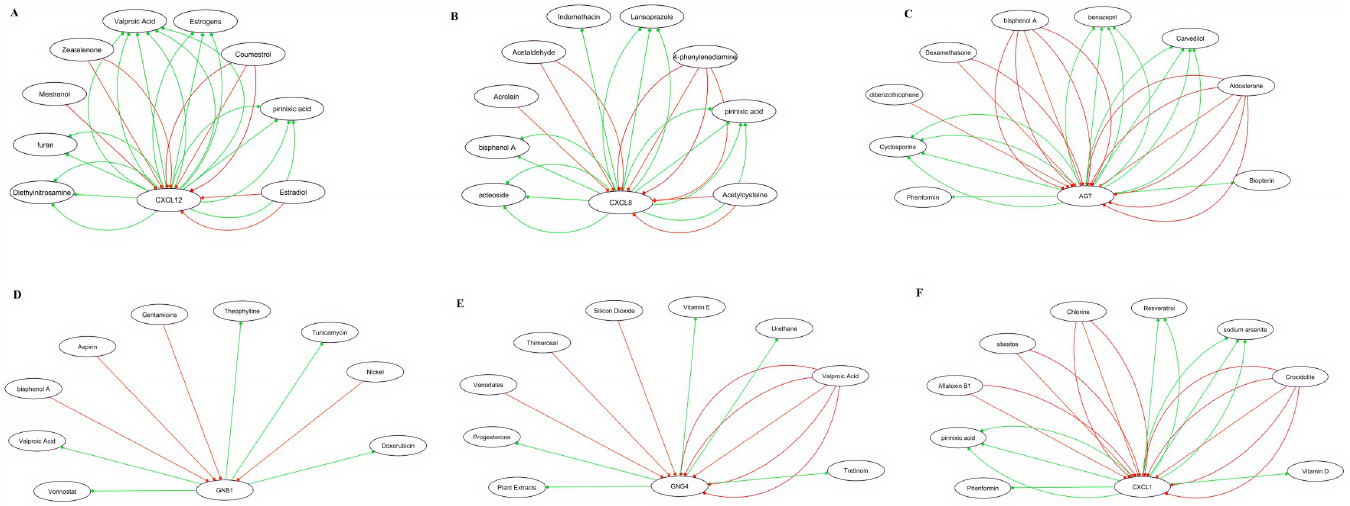
Fig 16. Real hub gene-drug interaction network of the identified real hub genes. Panels A–F indicates the available chemotherapeutic drugs in CTD that decrease or increase the expression levels of the real hub genes. (A) Real hub gene-drug network of CXCL12; (B) Real hub gene-drug network of CXCL8; (C) Real hub gene-drug network of AGT; (D) Real hub gene-drug network of GNB1; (E) Real hub gene-drug network of GNG4; (F) Real hub gene-drug network of CXCL1. Red arrows indicate the chemotherapeutic drugs that could increase the expression levels of the real hub genes, while green arrows indicate the chemotherapeutic drugs that could decrease the expression levels of the real hub genes. The numbers of arrows between chemotherapeutic drugs and real hub genes in the network represent the supported numbers of previous studies reported in